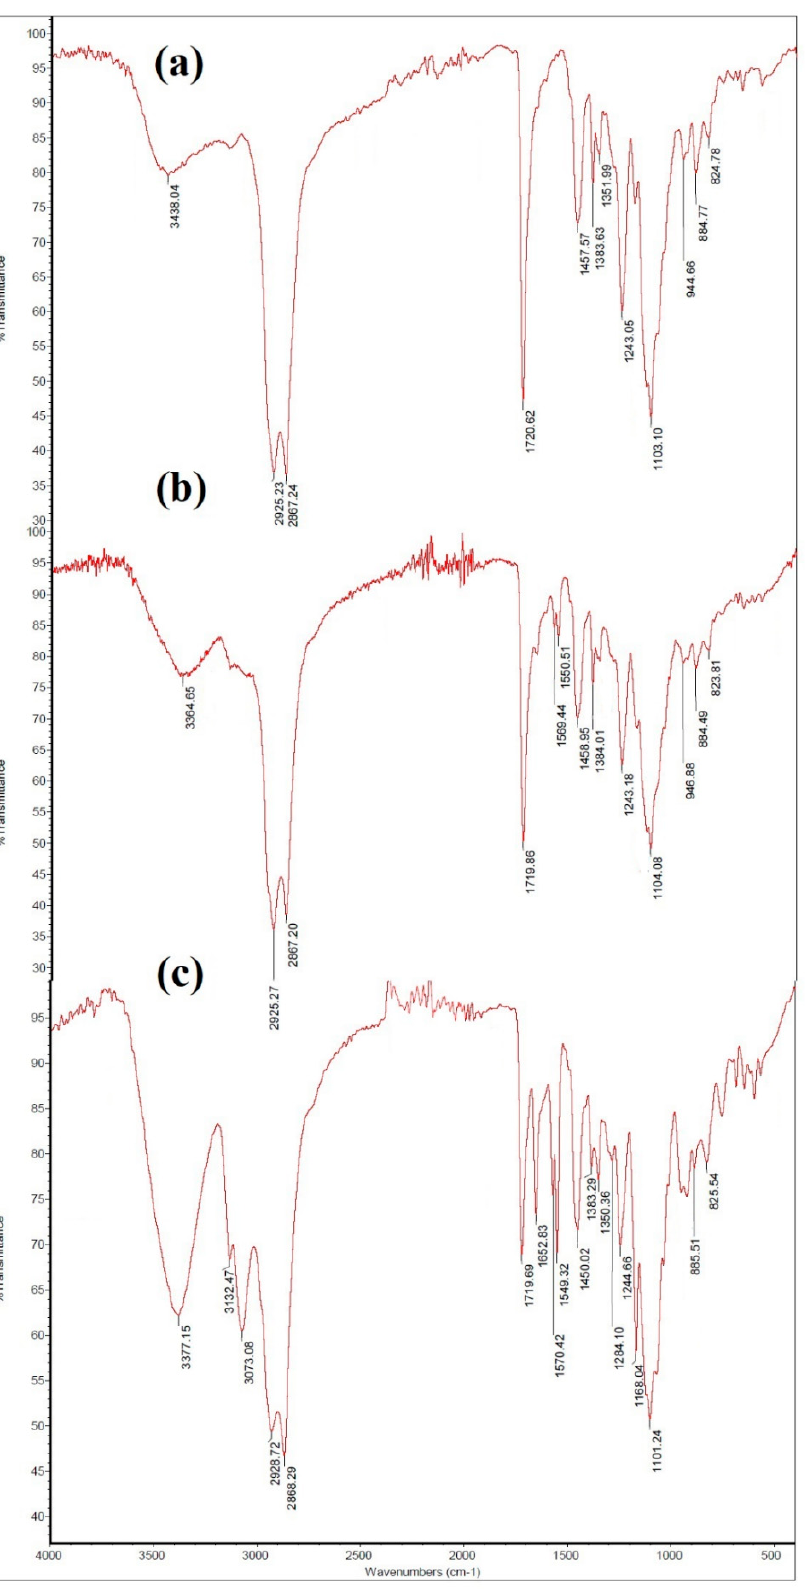
Figure 1. FTIR spectra of ( a ) ATI, ( b ) ATHI-IL, and ( c ) ATEI-IL. The 1 HNMR spectra of ATI, ATHI-IL and ATEI-IL are shown in Figure 2a–c, respec- tively. Figure 2a confirms the esterification of abietic acid with tetraethylene glycol by the appearance of a triplet peak at 3.42–3.56 ppm related to (-CH 2 CH 2 O) and the appearance of the -OH broad peak at 5.3 ppm. Moreover, the appearance of doublet peaks related to